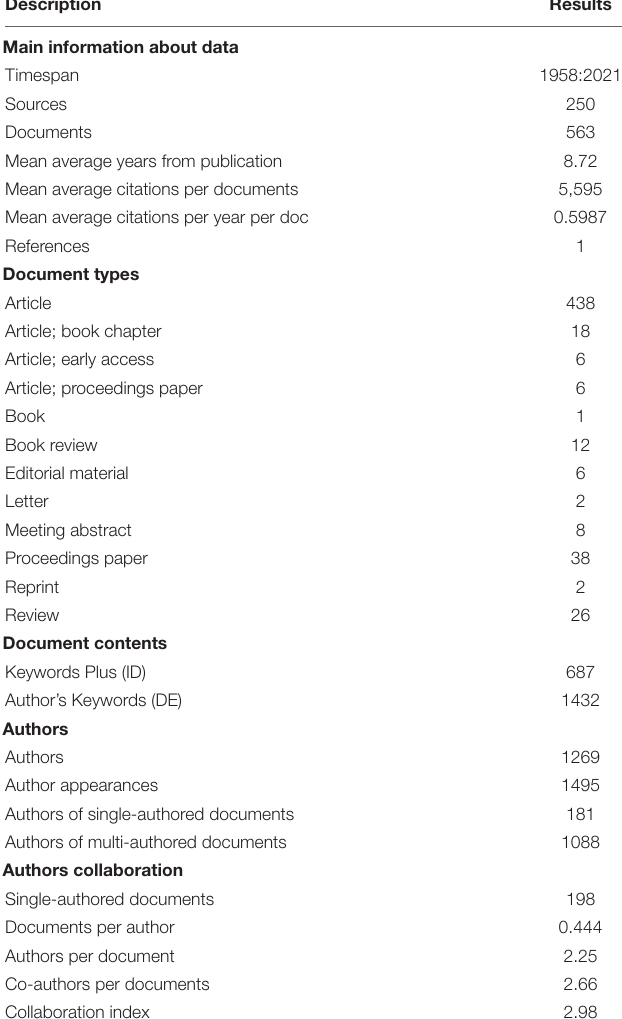
TABLE 1 | Description, search characteristics, and results found in art